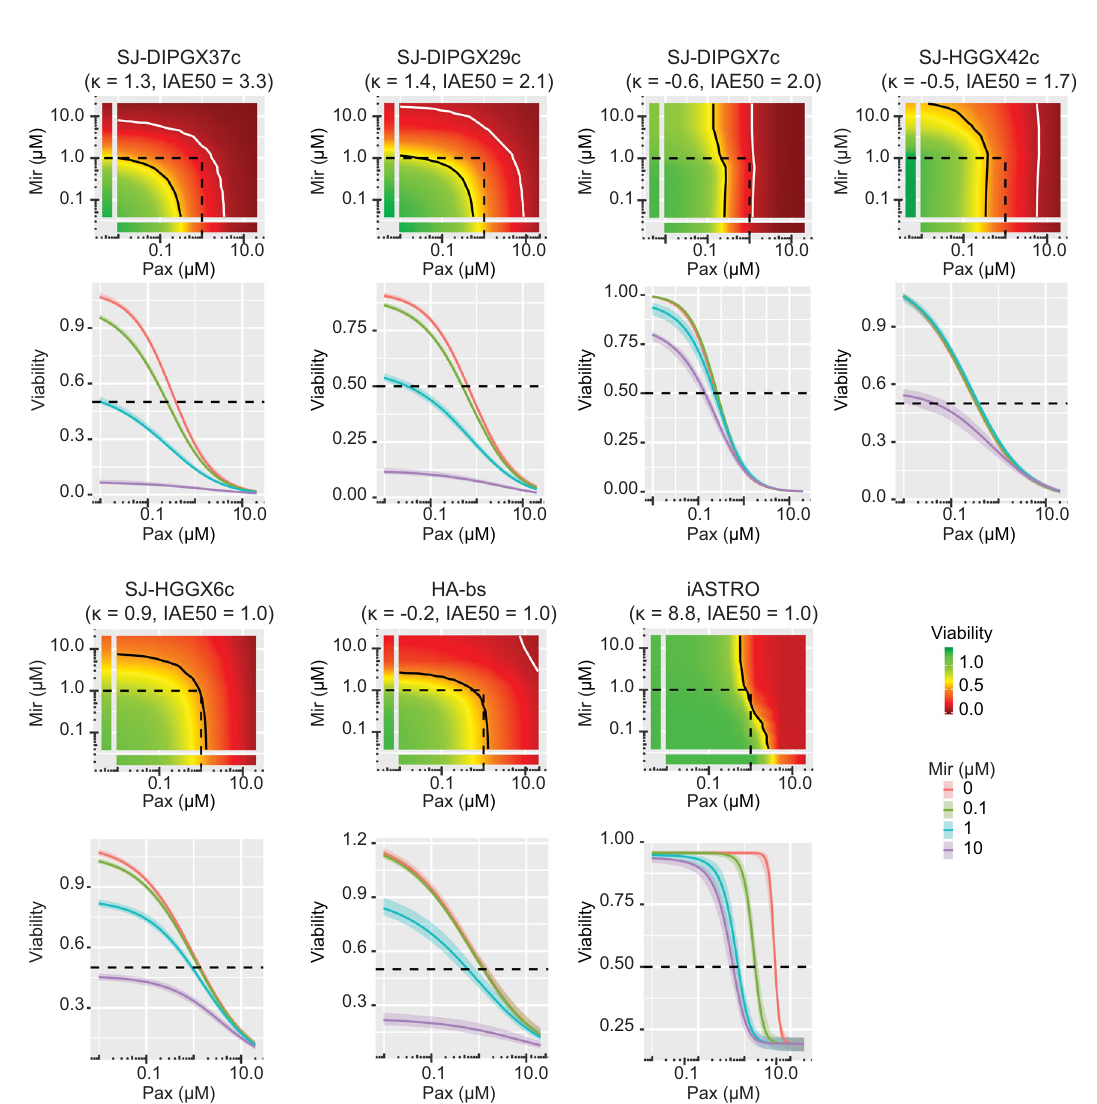
Fig. 7 Paxalisib and mirdametinib drive synergistic growth inhibition in a subset of pHGG cell lines. The BRAID model presents synergistic effects of paxalisib (pax) and mirdametinib (mir) following a 7-day treatment in 7-cell lines: H3.3 K27M DIPGs; SJ-DIPGX37c, SJ-DIPGX29c, SJ-DIPGX7c, H3.3 G34R pHGGs; SJ-HGGX42c, SJ-HGGX6c, and astrocyte controls HABS and iAstro. The parameter κ measures the type of interaction: κ < 0 implies antagonism, κ = 0 implies additivity, and κ > 0 implies synergy). The index of achievable ef fi cacy (IAE) quanti fi es the degree to which the drug combination achieves a minimal level of ef fi cacy within a de fi ned concentration range. Higher IAE means the combination was more ef fi cacious. In this experiment, it was de fi ned as a 50% reduction of cell viability (black line) at concentrations ≤ 1 μ M (dotted lines). The 90% reduction of viability isobole (white line) is included for reference.